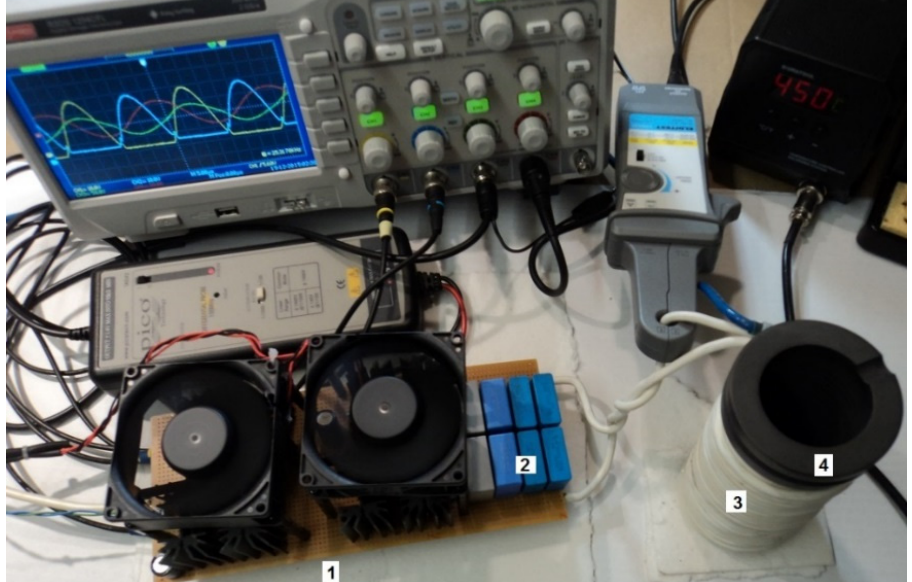
Figure 6. A model of self-resonant converter for induction heating: 1—IGBT transistors; 2—resonant capacitor tank; 3—inductor; 4—graphene crucible. The used measurement equipment is as follows: oscilloscope RS PRO RSDS1204CFL; current probe ELDITEST CP6220; voltage differential probe Pico.